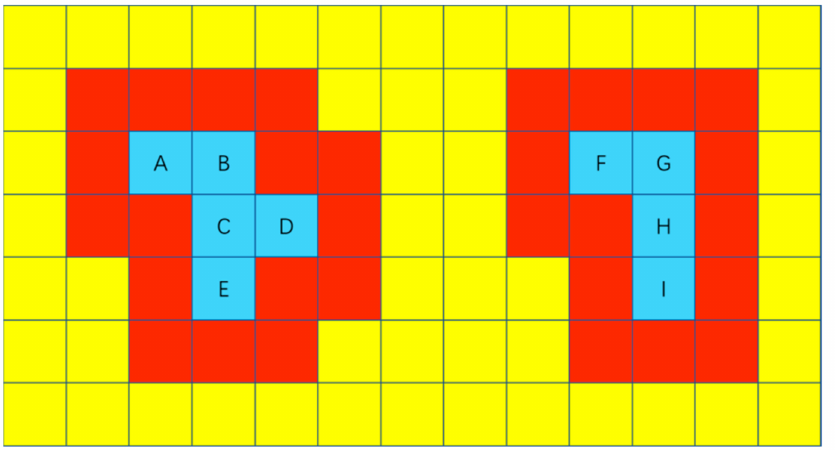
Figure 7. Schematic diagram of mountain vertex extraction based on the Improved Eight-Connected Extraction Algorithm.